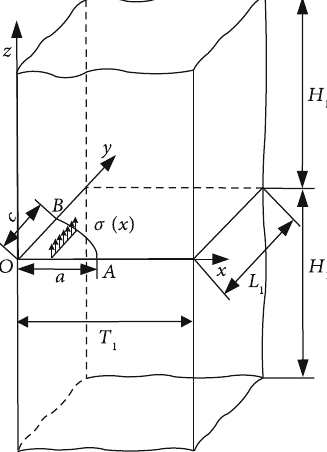
Figure 4: Quarter-elliptical corner crack in fi nite thickness plate